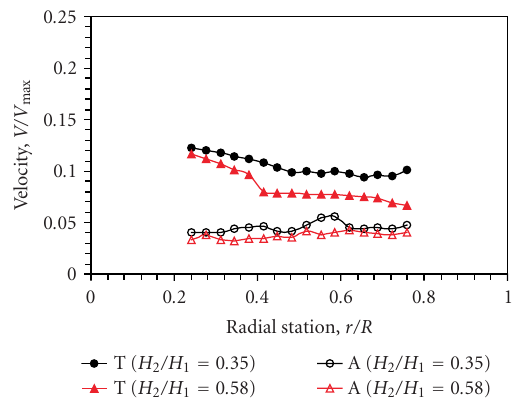
Figure 12: Comparison of di ff erent deck heights for section 5 ( z/Z = 0 . 438).